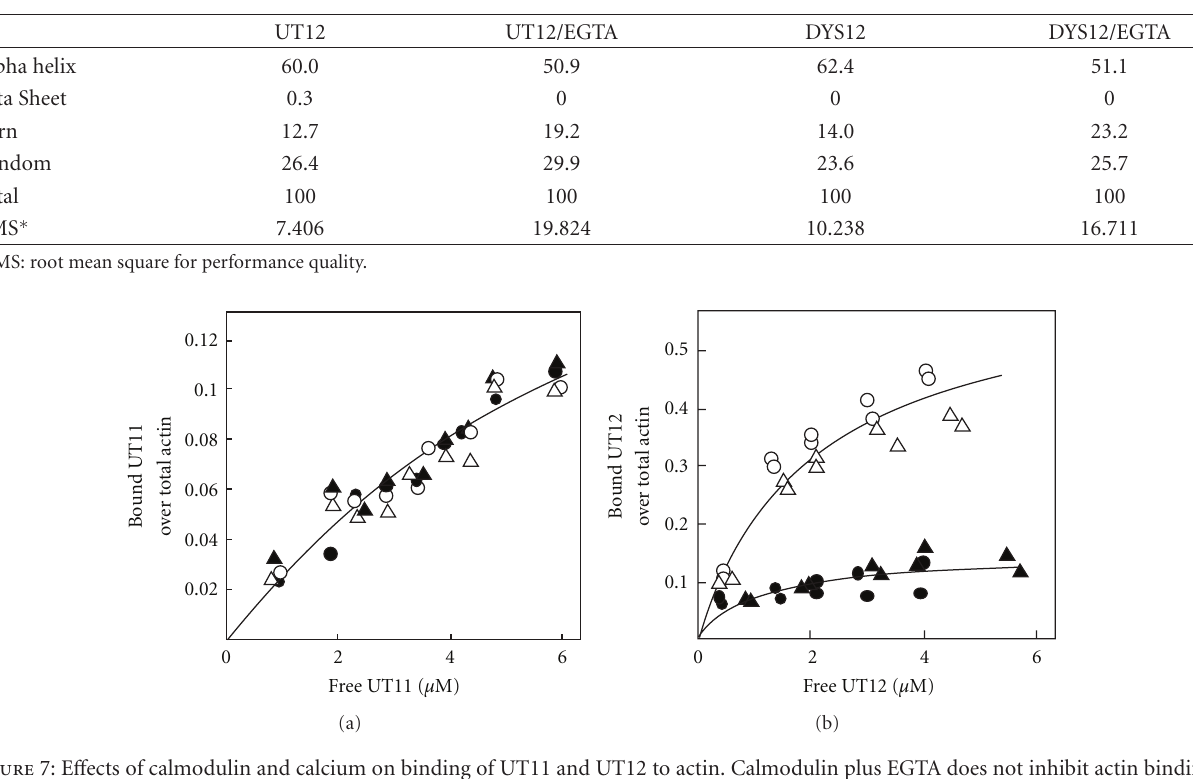
Table 4: Circular dichroism parameters of UT12 and DYS12 in the presence and the absence of EGTA each with an excess of 0.5 mM CaCl 2 (spectrum analysis from 190 to 260 nm, for details see the Method section).